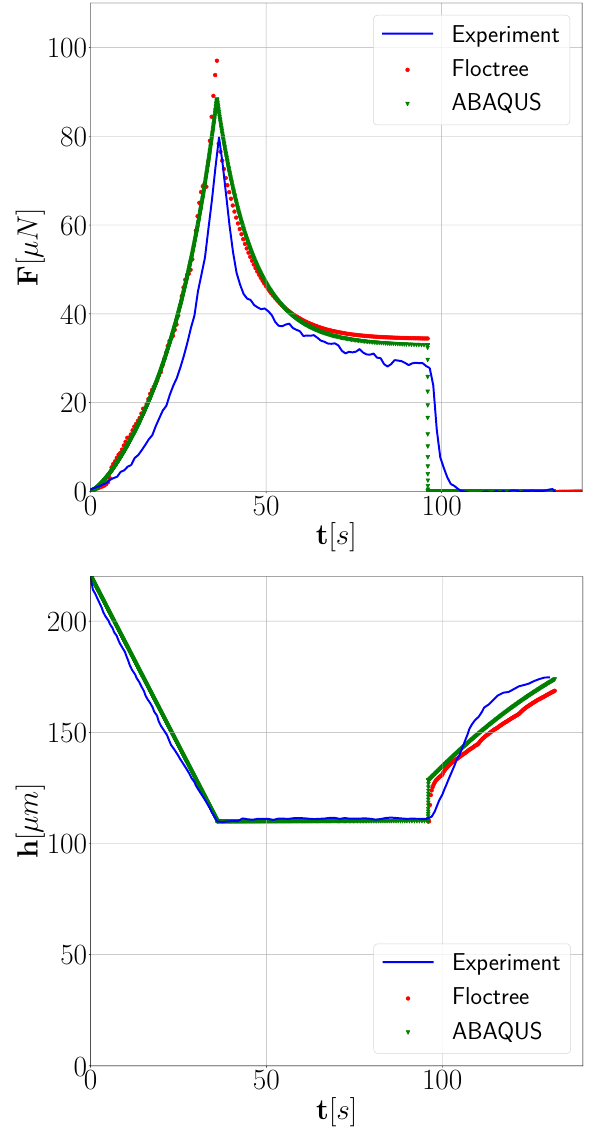
Figure 2. The reaction force acting on the upper plate ( top ) and the spheroid height ( bottom ) in the case of instantaneous release of the